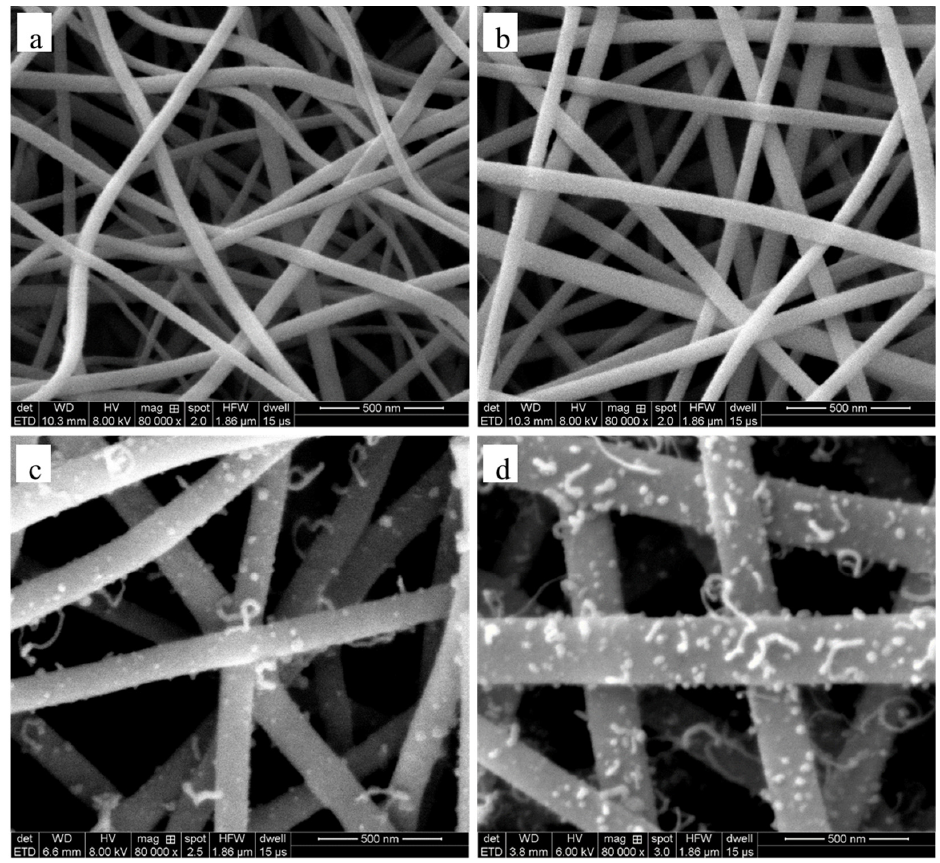
Figure 10. SEM images of the spent catalysts made from the solution with different metal ion contents: ( a ) C10; ( b ) C20; ( c ) C30; ( d ) C40.